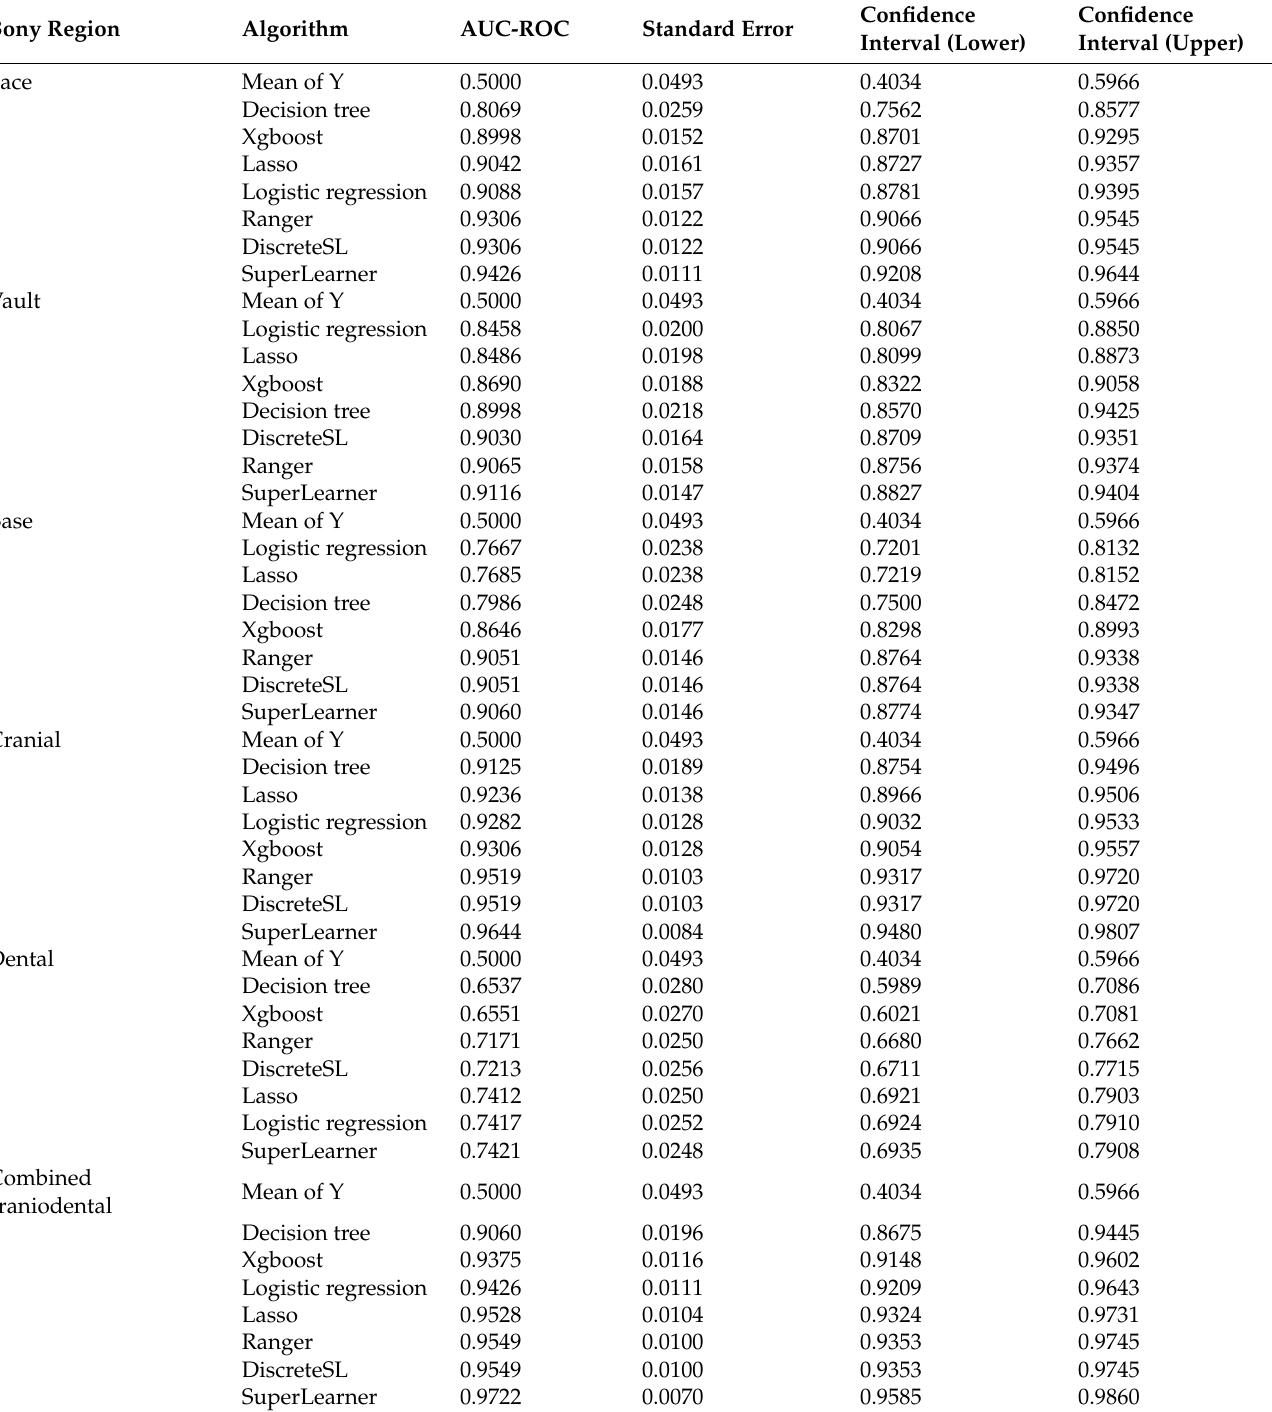
Table 5. Cross-validated AUC-ROC statistics for the six different measurement regions. 0.5 is the equivalent of random guessing; 1 means perfect